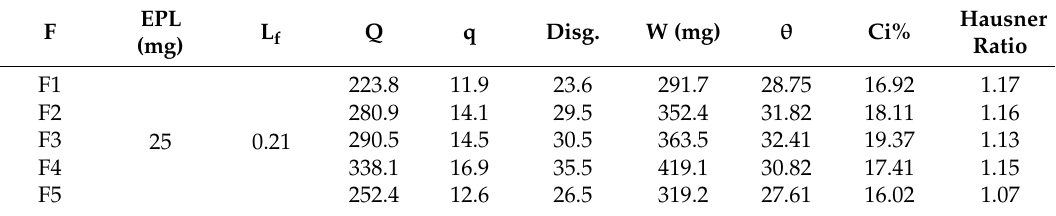
Table 2. Composition and pre-compression characterization of EPL-NE liquisolid formulations.